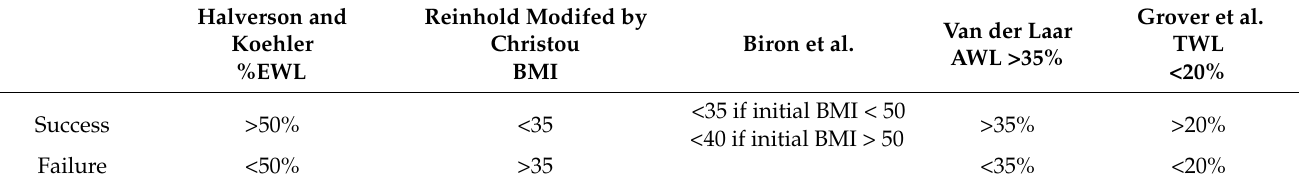
Table 1. Success and failure criteria according to literature